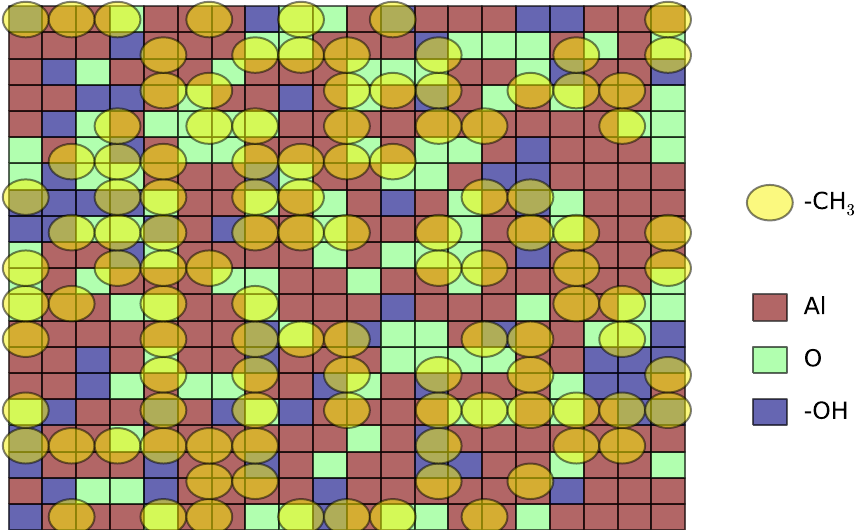
Figure 5. A snapshot of a 35 nm 2 portion of the ALD growth surface corresponding to θ = 0 . 6 and θ = 0 . 5 O Me